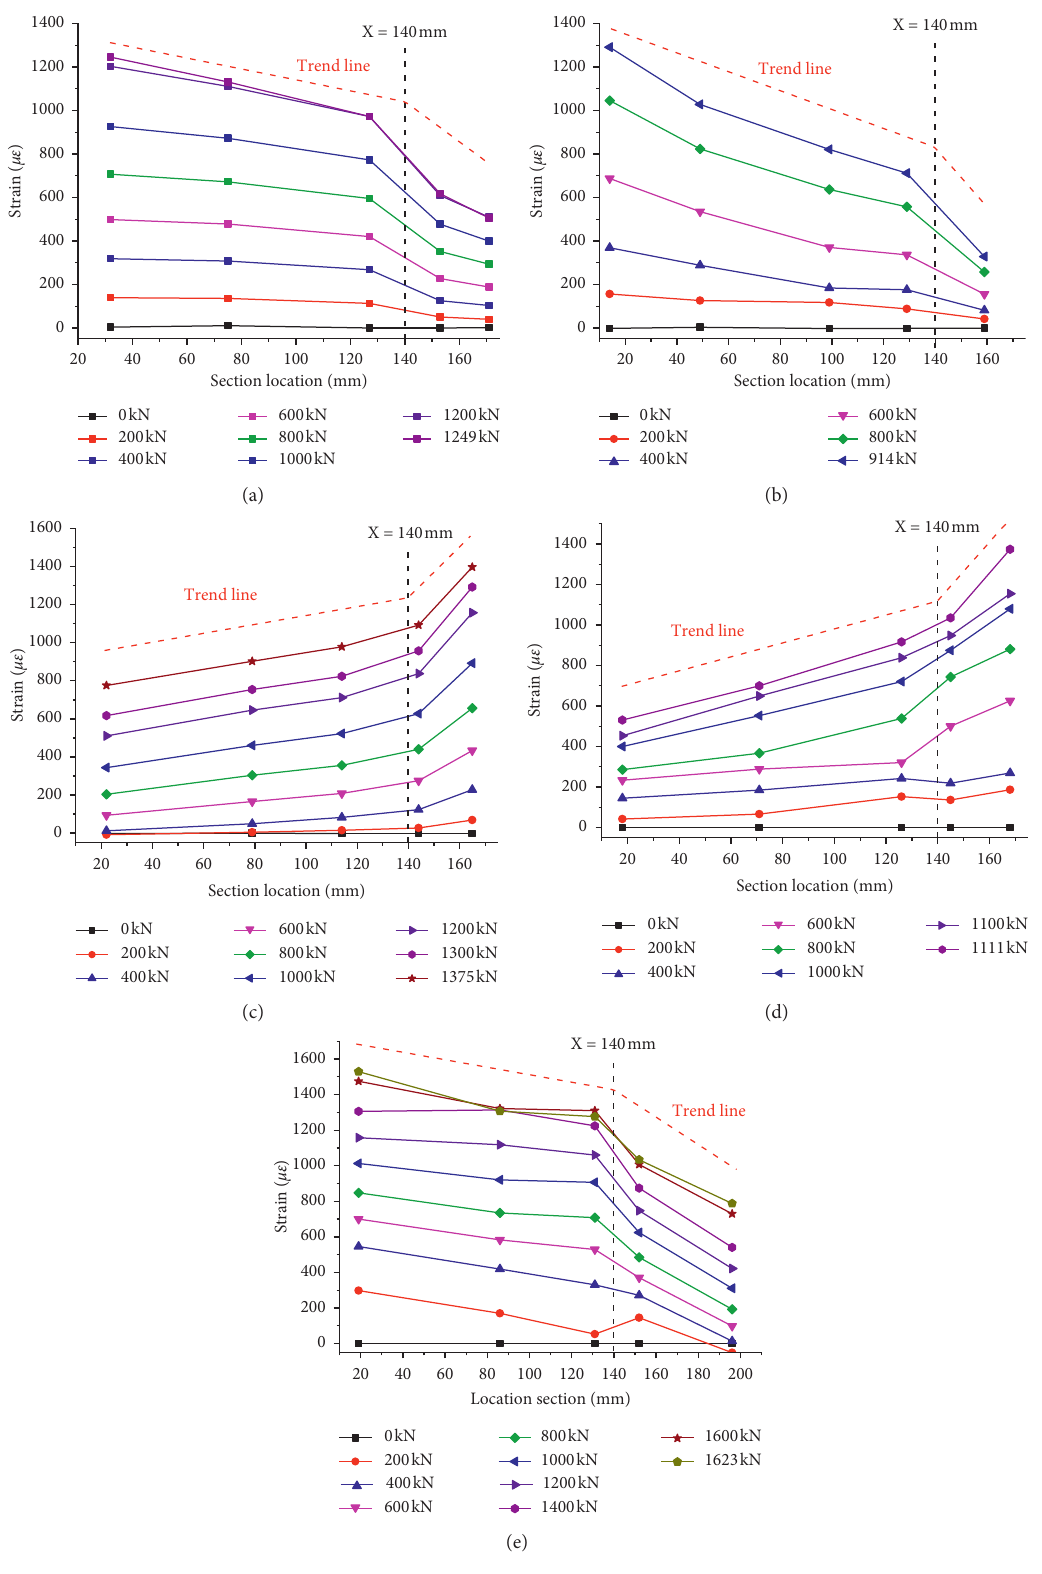
Figure 10: Strain distribution of group U . (a) U35-L-20-1. (b) U35-L-40-1. (c) U35-R-20-1. (d) U35-R-30-1. (e)